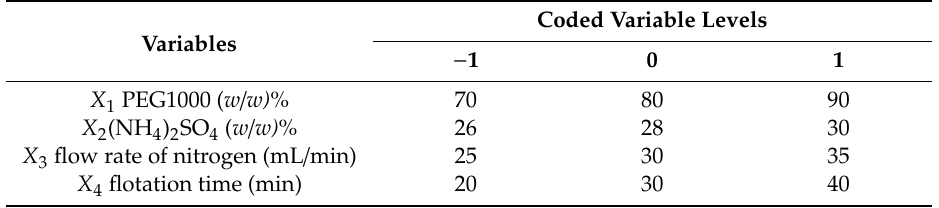
Table 1. The factors and levels in the response surface design for optimizing the separation of ovalbumin (OVA) by aqueous two-phase flotation (ATPF). Coded Variable Levels Variables − 1 0